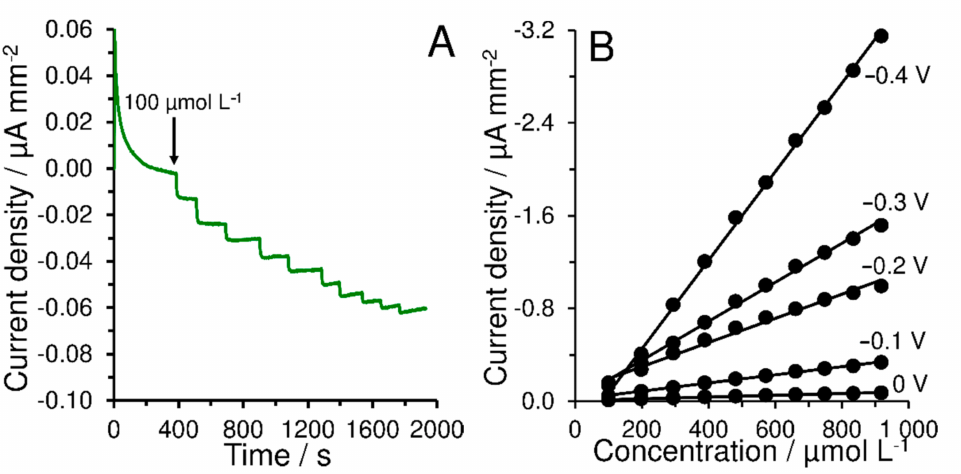
Figure 4. Typical amperometric response of GCE/MWCNTs/CBCC-Nafion ® to different concentra- tions of H 2 O 2 (100–920 µ mol L − 1 ) obtained at 0.0 V vs Ag/AgCl ( A ) and calibration curves obtained at different applied potentials ( B ). Each measurement was performed in 0.1 mol L − 1 PB (pH 7.0) at stirring speed of 400